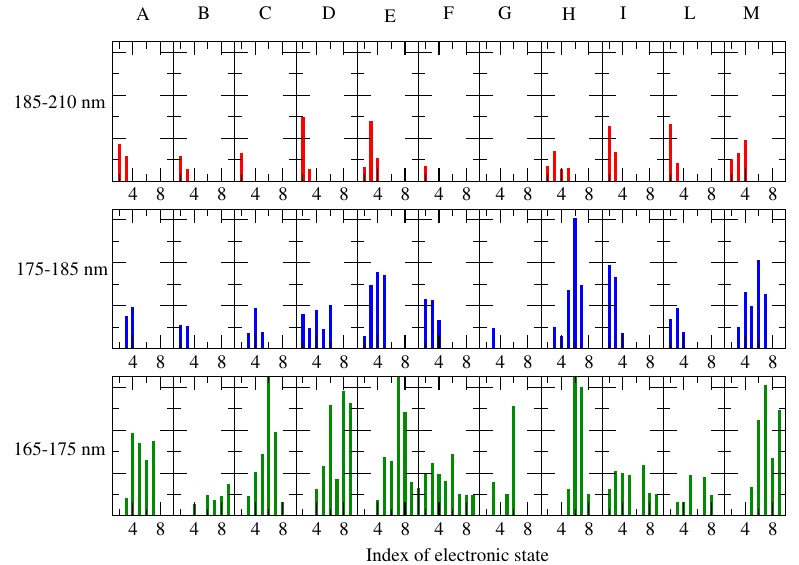
Figure 11. The electronic ground–excited (perturbed) state transitions involved in the calculated ECD spectra of Beta-Glu, as obtained for each RC conformation. Note that for clarity, only the transitions showing a maximum intensity higher than 1.0 M − 1 cm − 1 were taken into